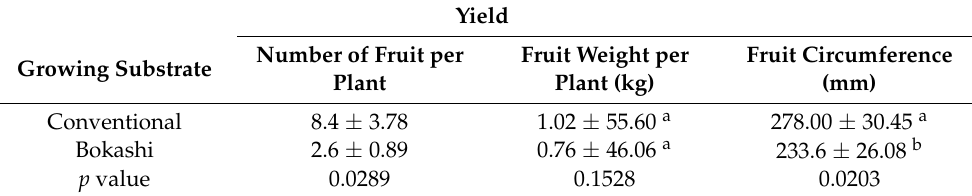
Table 4. Effects of conventional and bokashi hydroponics on fruit yield of bell peppers. Yield Number of Fruit per Fruit Weight per Fruit Circumference Growing Substrate Plant Plant (kg) (mm) Conventional 8.4 ± 3.78 1.02 ± 55.60 a 278.00 ± 30.45 a Bokashi 2.6 ± 0.89 0.76 ± 46.06 a 233.6 ± 26.08 b p value 0.0289 0.1528